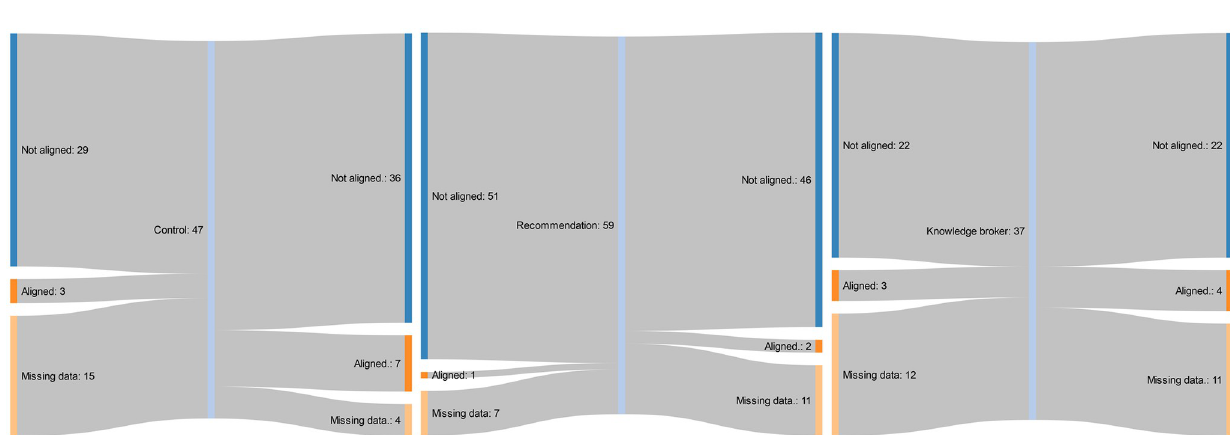
Fig 4. Flow of subacute rehabilitation units from baseline to follow-up policy recommendations alignment, by implementation strategy group.